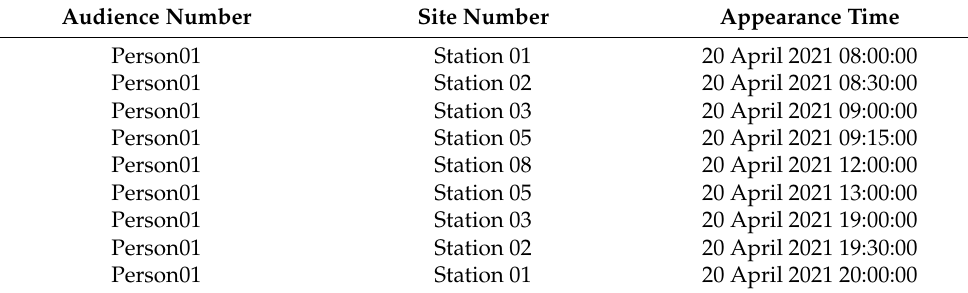
Table 5. Specific audience data after unified time.